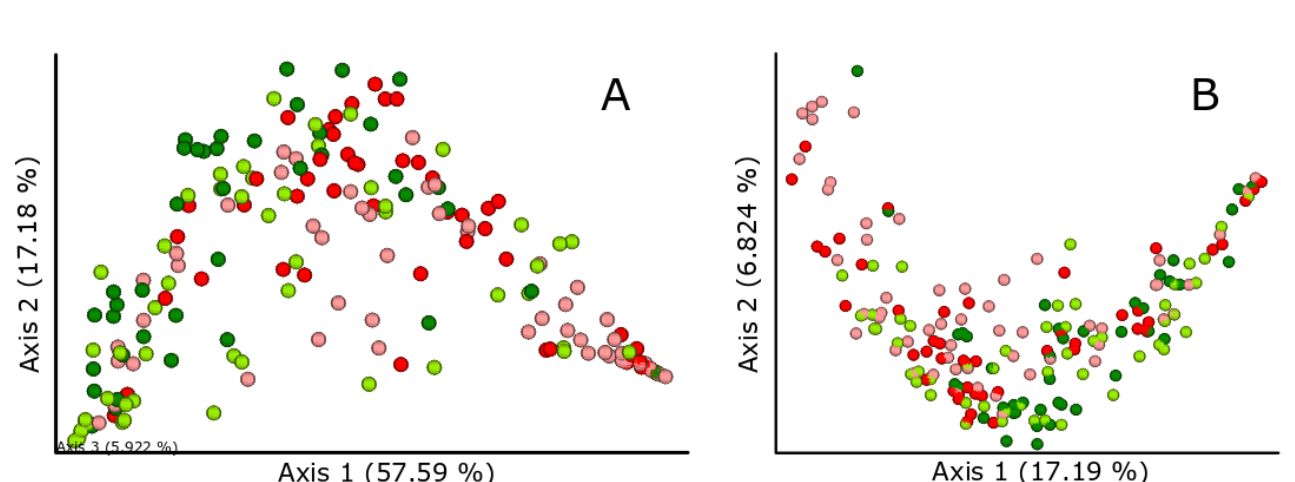
Figure 4. Principal coordinate analysis based on ( A ) weighted and ( B ) unweighted UniFrac distance matrices exploring the effects in the bacterial gut community of the supplementation with Allium - derived PTSO in the diet of gilthead seabream juveniles (red: foregut—control fish; pink: hindgut—control; green: foregut—treated fish; light green: hindgut—treated fish). Percentages show the proportion of variance explained by each axis. Sample size was 48 for control foregut, 55 for control hindgut, 42 for Allium -supplemented foregut, and 51 for Allium -supplemented hindgut. Significant differences appeared between tanks in the same treatment group for both UniFrac distance matrices (Table 2, Figure S3). These differences in gut region and tank could not be observed graphically in the PCoA since it does not take into account the 100% of the variance (74.77% in weighted UniFrac and 24.01% in unweighted UniFrac) (Figures S2 and S3).